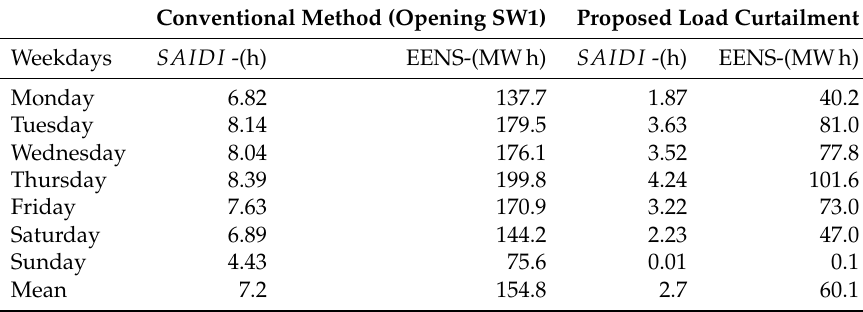
Table 1. Assessment of the simulation results.